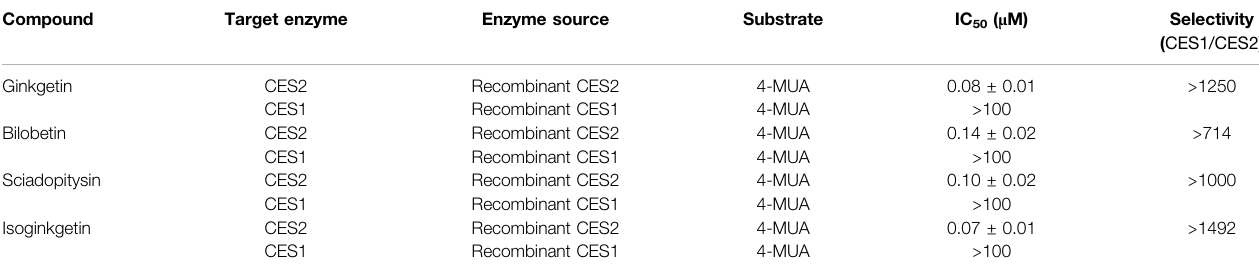
TABLE 2 | The inhibitory effects of four bi fl avones from Ginkgo biloba against CES-catalyzed 4-MUA hydrolysis.